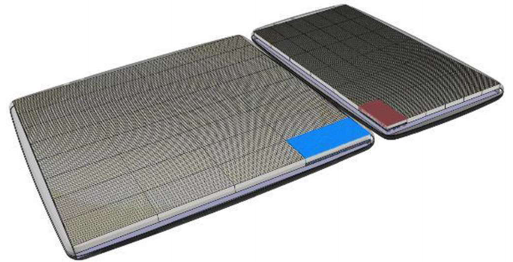
Figure 37. Microwave Liquid Crystal (MLC)-based receive (blue) and transmit (red) ESAs made up of a variable number of tiles, where each tile has a fixed number of radiating elements, depending on requirements. This visualization shows one possible configuration for a high-gain non-GEO antenna. Courtesy of ALCAN Systems